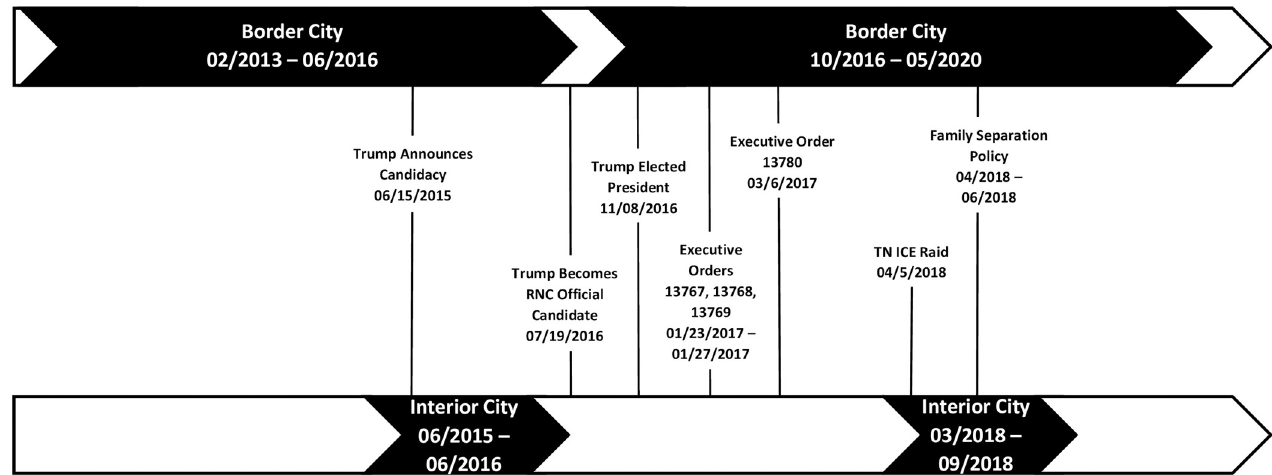
Fig 2. Timeline of study sample collection. These two timelines show the timing of sample collection in the two locations of our study in relation to federal policies shared by both sites (shown by lines connecting to both timelines) and a local event (in the interior city) that impacted immigrants during the post- candidacy period. Three Executive Orders (13767, 13768, and 13769) were issued by the President within the last week of January 2017. These orders collectively included demands for a border wall (13767), expanded use of detention of immigrants (13768), limited access to asylum, enhanced enforcement along the border and increased the number of ICE agents (13768, 13769), prohibited sanctuary jurisdictions from receiving federal funding (13768), and limited travel from Muslim majority countries (13769). Additionally, a policy specifically aimed at separating families at the border was enacted in spring of 2018. In TN specifically, an ICE raid on a meatpacking plant occurred a few hours away, possibly the largest raid of Trump administration with 86 individuals detained and 11 arrested. All together, these policies sent a collective message that immigrants were not welcome and increased anti-immigrant media attention during this